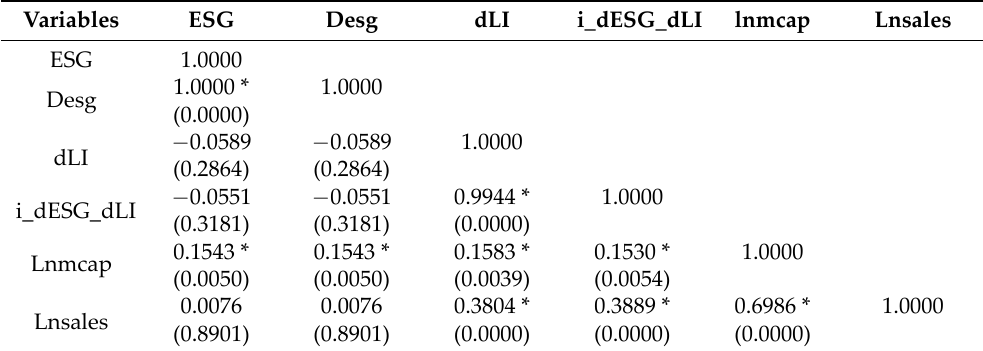
Table 3. Correlation